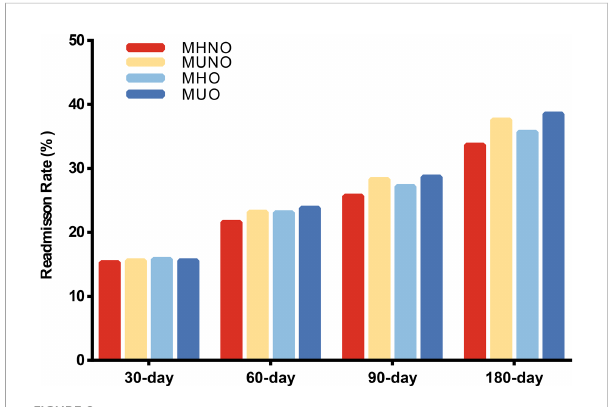
FIGURE 2 Readmission rate among different metabolic obesity phenotypes in four follow-up days. MHNO, metabolically healthy non-obese; MUNO, metabolically unhealthy non-obese; MHO, metabolically healthy obese; MUO, metabolically unhealthy